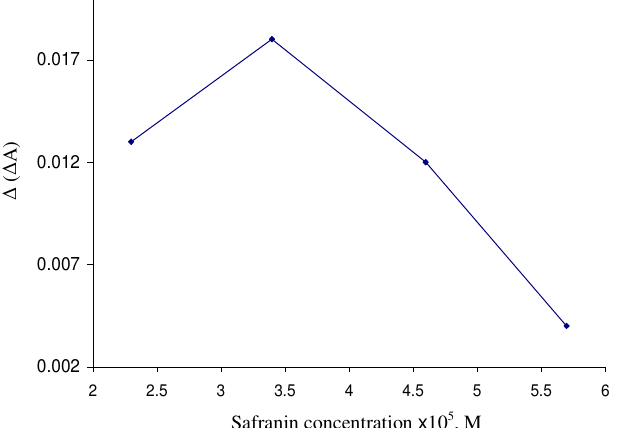
Figure 4. Effect of safranin concentration on the analytical signal. Conditions: H BrO 3− , 2.7 × 10 −3 M, formaldehyde 0.4 µ g/mL, temperature, 28 °C and time of 1.0 min from initiation of the reaction.